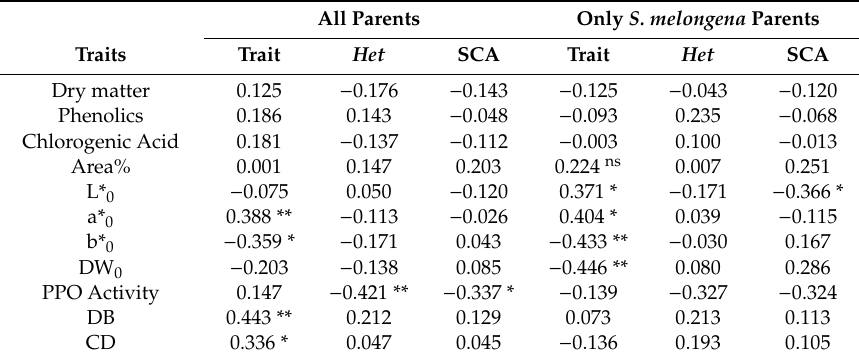
Table 6. Correlations between genetic distances among parents and hybrid trait values, heterosis (Het), and specific combining ability (SCA).